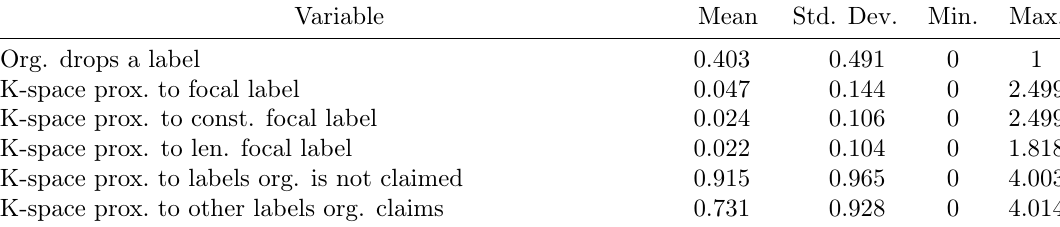
Table 2: Descriptive Statistics for Tests Involving the Hazard of Dropping a Label. ( N = 10 , 908